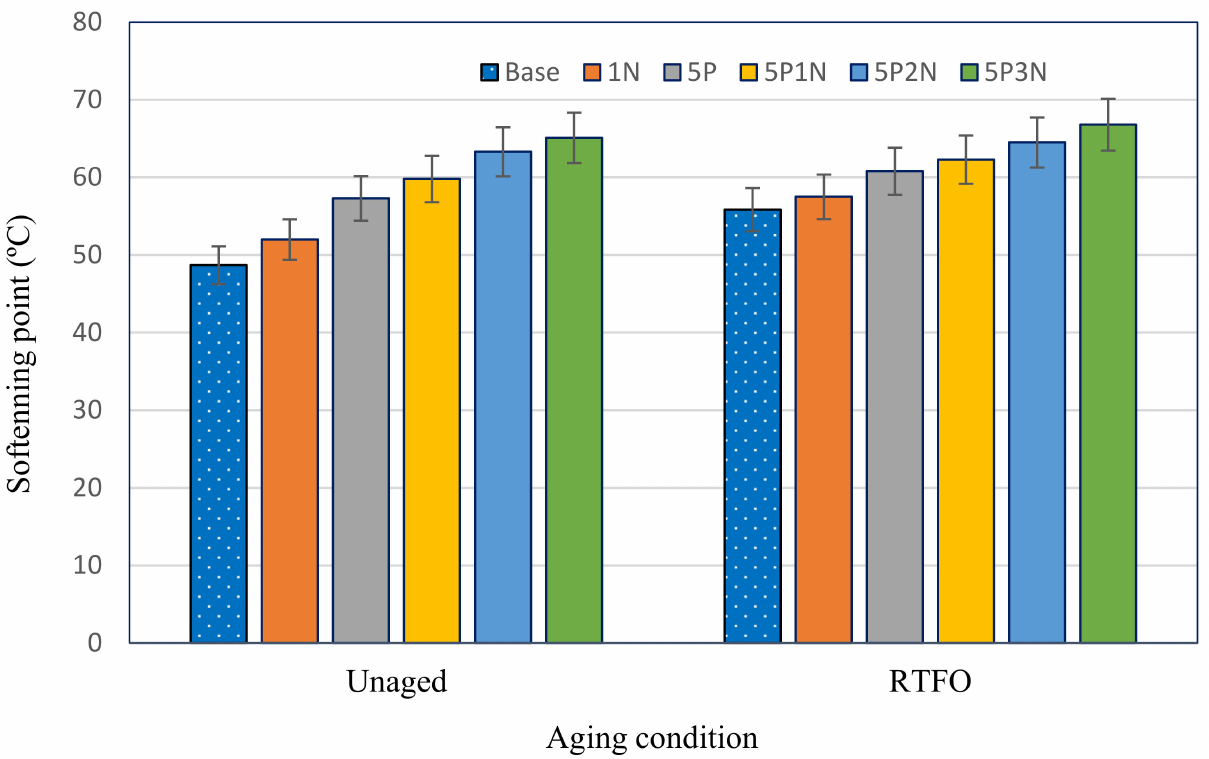
Figure 4. Softening point of AH-70 asphalt modified with PVC and